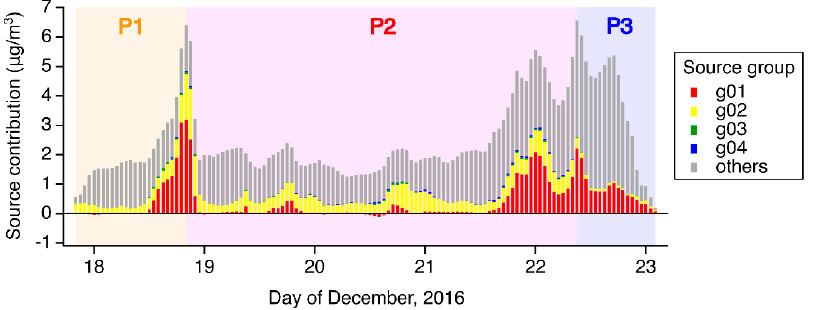
Figure 7. Temporal variation of source contributions of g01, g02, g03, g04, and others calculated for the CMAQ base-case simulation.